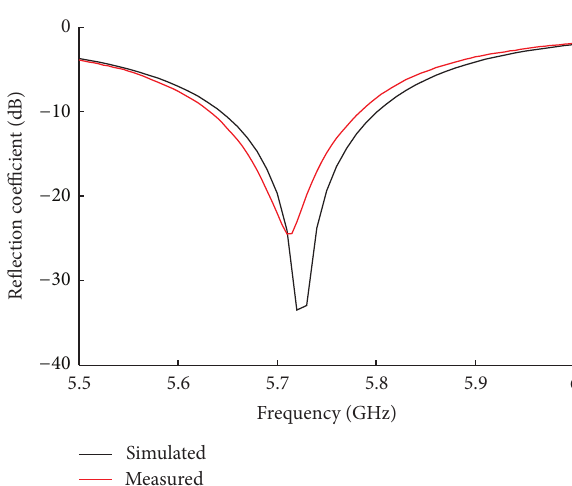
Figure 18: Reflection coefficients of the two-element